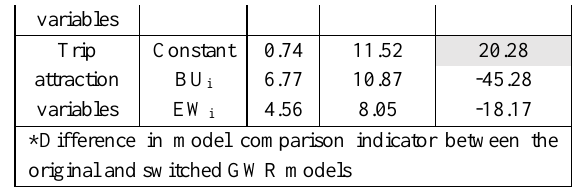
Table 5. Results of testing spatial non-stationarity for